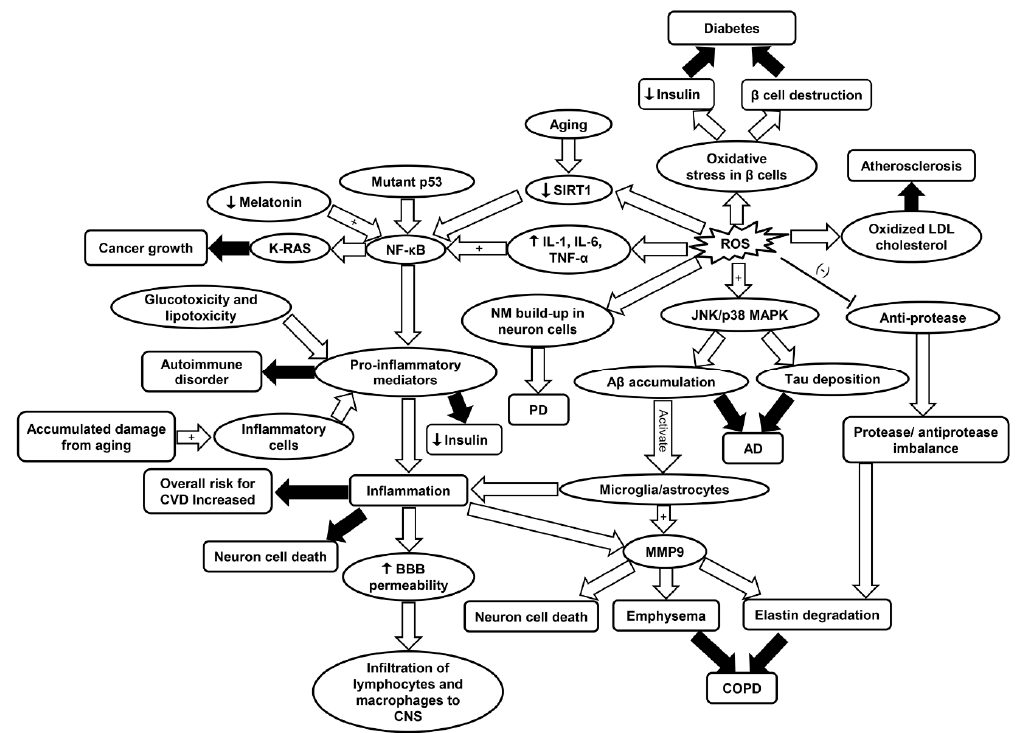
Figure 7. Schematic summarizing the primary molecular signaling involved in different diseases including CVD, cancer, AD, PD, COPD, diabetes, and RA. AD, Alzheimer’s disease; A β , amyloid beta plaques; BBB, blood brain barrier; COPD, chronic obstructive pulmonary disease; CVD, cardiovascular disease; IL-1, interleukin-1; IL-6, interleukin-6; JNK/p38 MAPK, c-Jun N-terminal kinase/ p38 mitogen-activated protein kinase; LDL, low density lipoprotein; MMP9, matrix metalloprotease 9; NF- κ B, nuclear factor kappa-light-chain-enhancer of activated B; SIRT1, sirtuin-1; PD, Parkinson’s disease; ROS, reactive oxygen species; TNF- α , tumor necrosis factor- α .